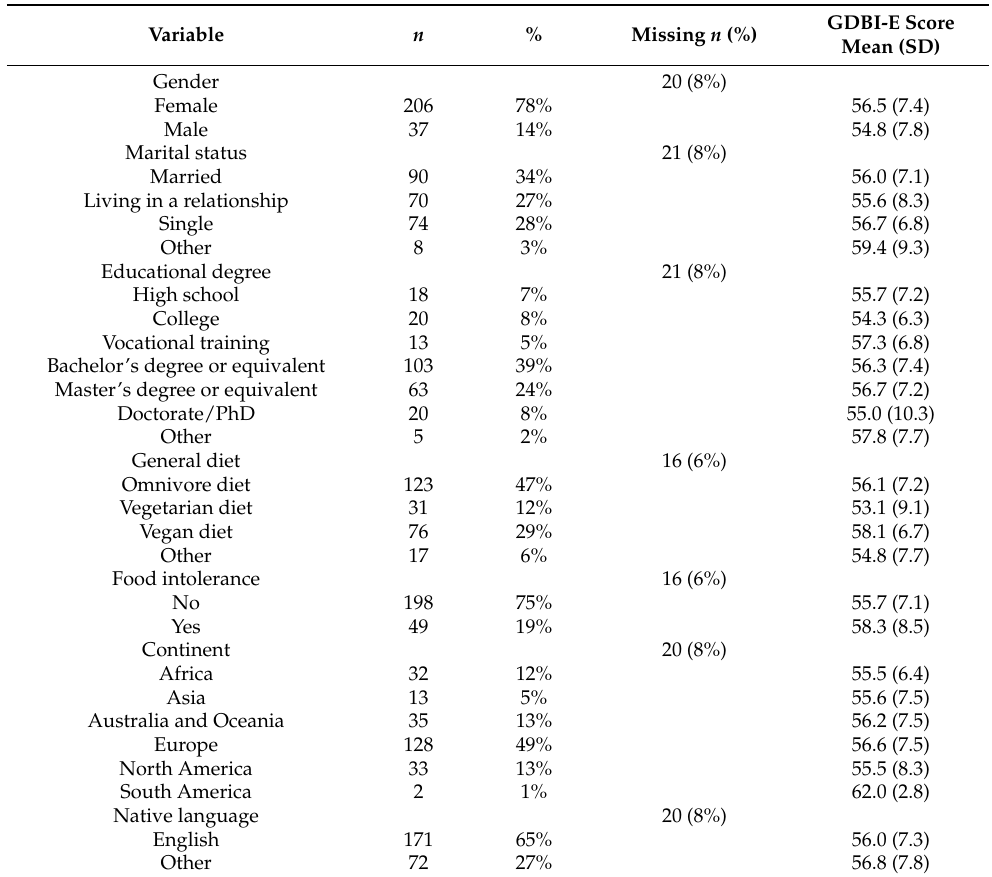
Table 2. Descriptive statistics of the study